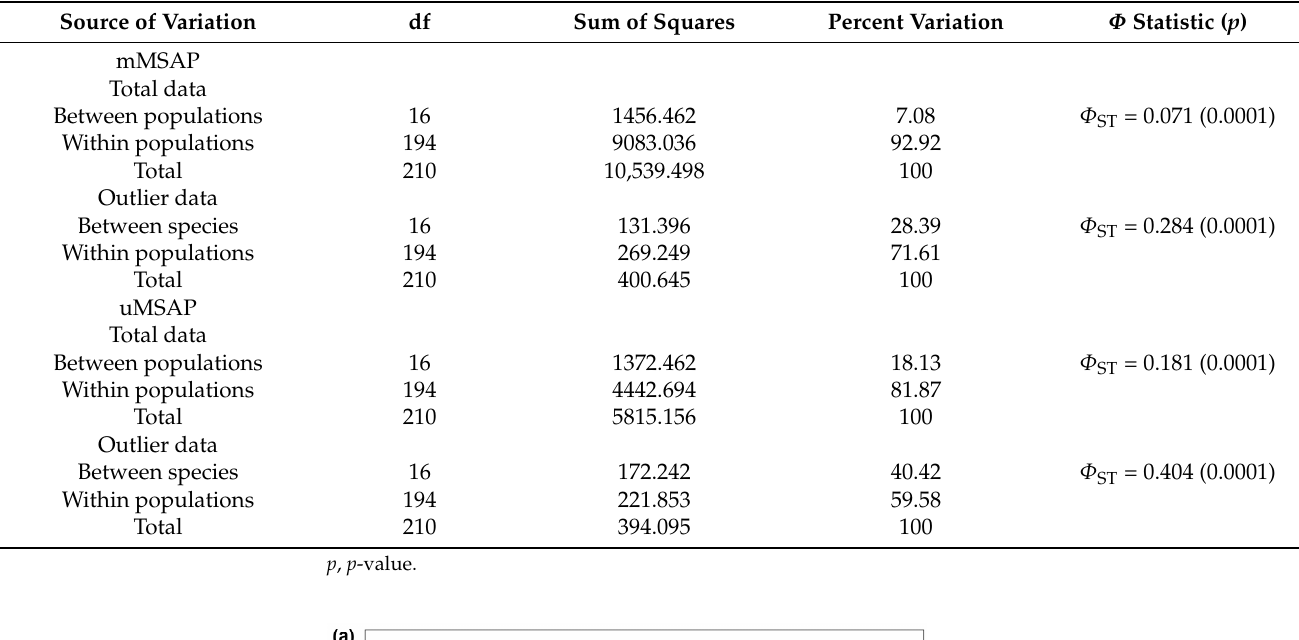
Table 2. Epigenetic differentiation between the 17 populations of Zingiber kawagoii based on the total and outlier mMSAP and uMSAP variation using an analysis of molecular variance (AMOVA).